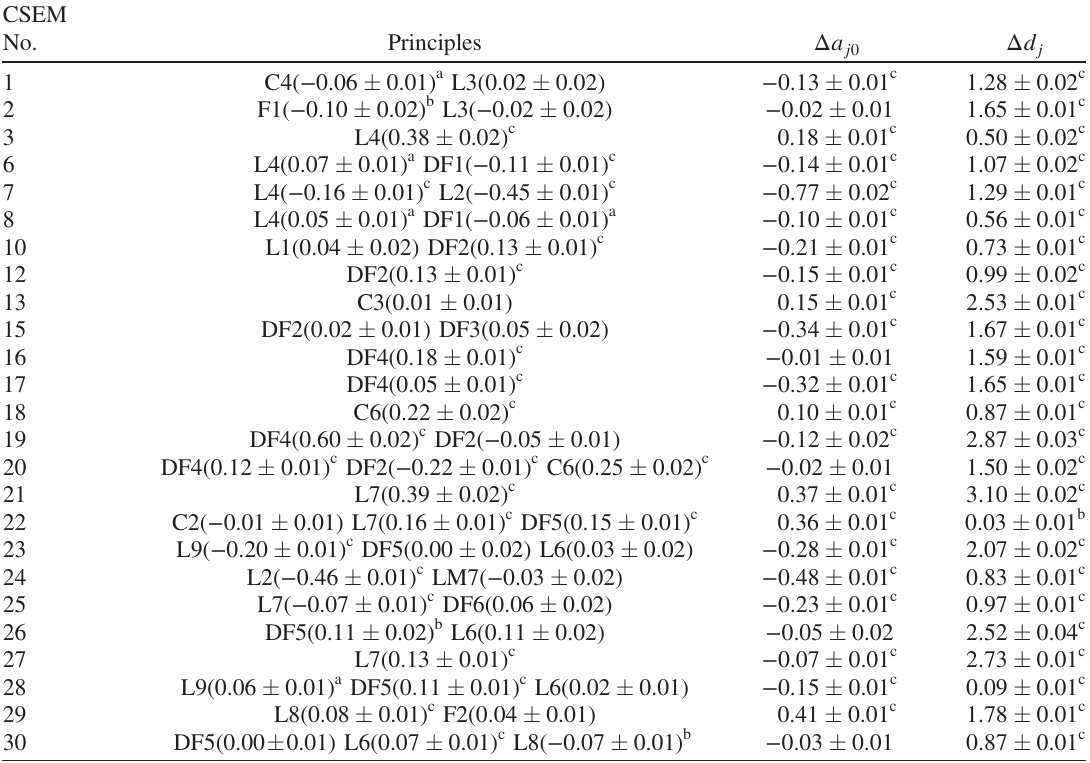
TABLE V. The difference in parameters between samples 1 and 2 using the optimal model for sample 1 (model M1-6). The number in parenthesis is the difference in discrimination Δ a jk for item j . Δ a j 0 is the difference in discrimination for a principle loaded on all items and Δ d j is the difference in the difficulty of the item. The standard error of each parameter is also reported. Each difference was t tested with a Bonferroni correction. A superscript of “ a ” represents the corrected equivalent of p < 0 . 05 , “ b ” p < 0 . 01 , and “ c ” p < 0 . 001 .